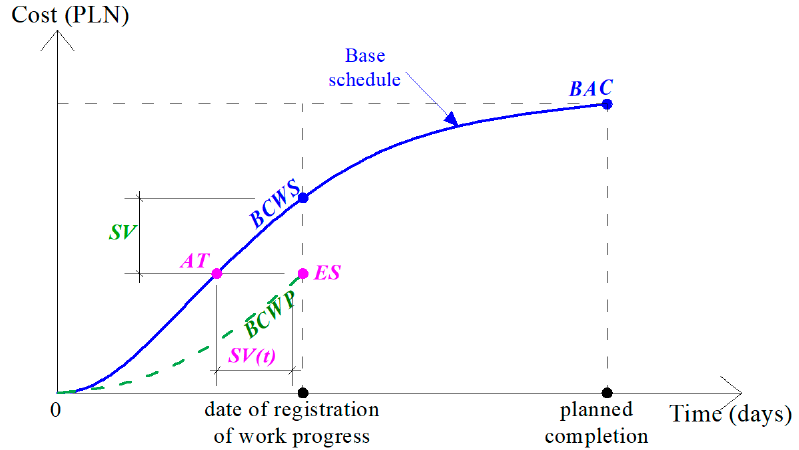
Figure 2. Graphic interpretation of simple parameters of the Earned Schedule (ES) method (description in the text). Source: [19]